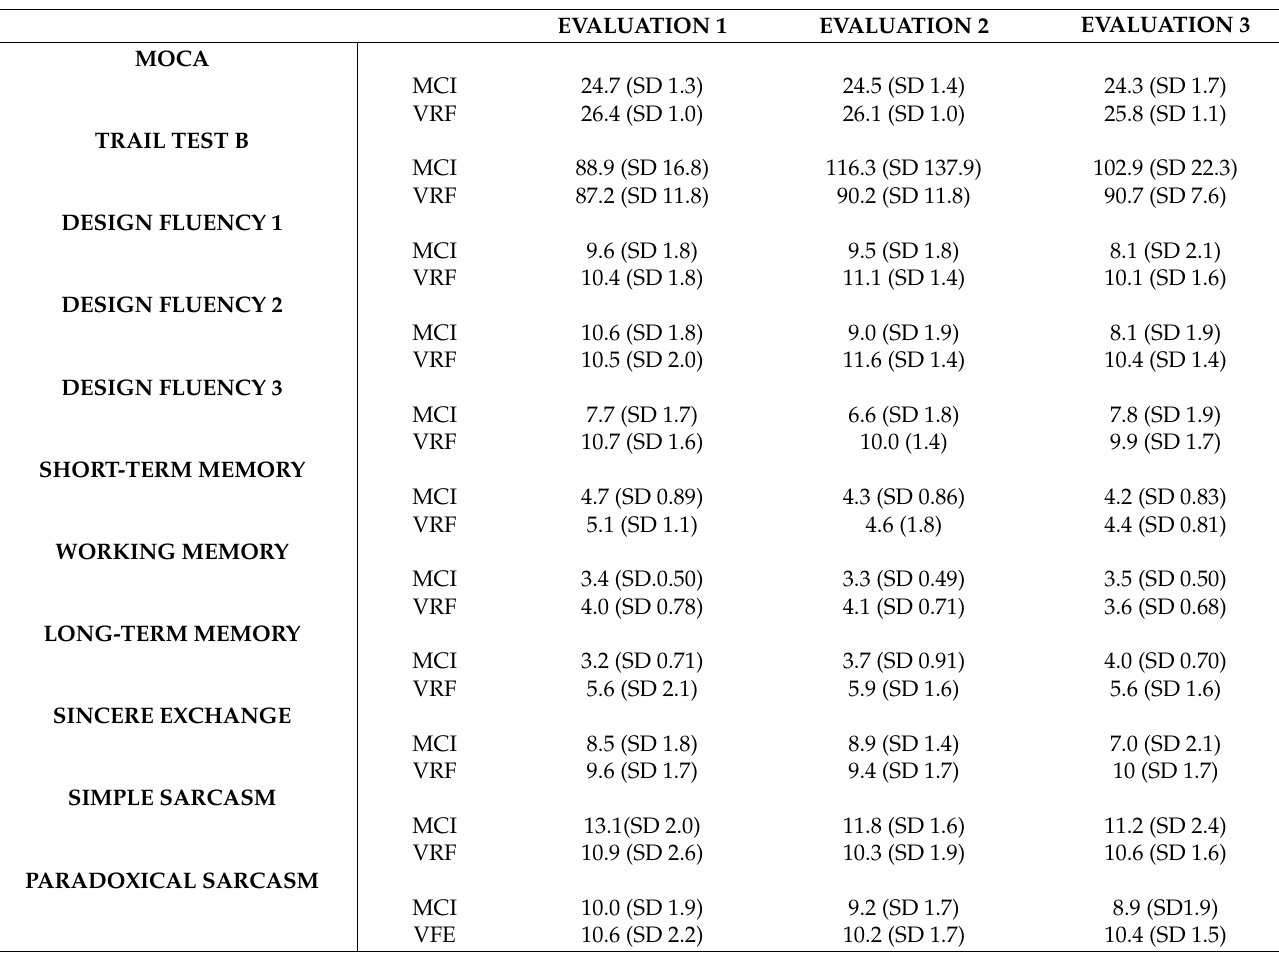
Table 1. Mean Score and Standard Deviation of the neuropsychological tests in the three times of